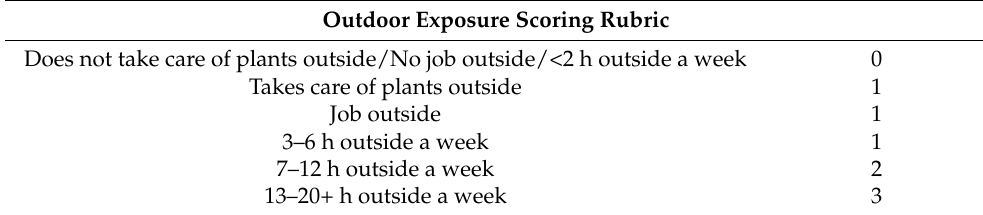
Table A10. Outdoor exposure assessment for survey answers. Participants were told to select all that applied, and scores were cumulative based on their